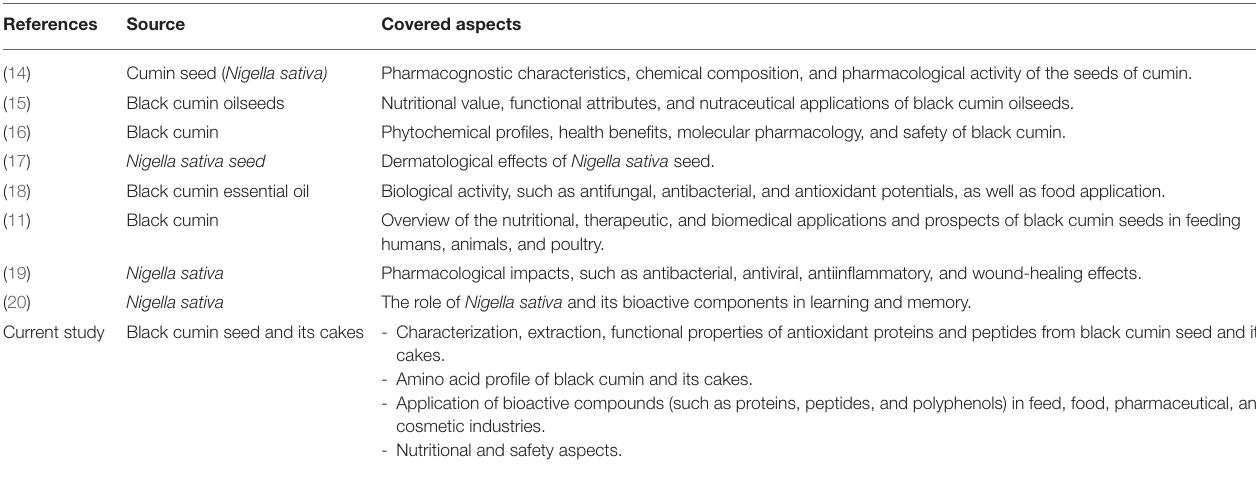
TABLE 1 | Comparison of current aspects with other published reviews on black cumin seeds ( Nigella sativa